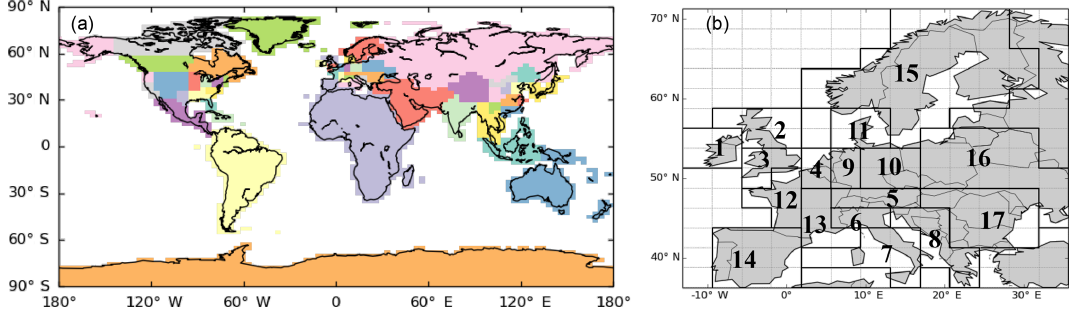
Figure 2. (a) Map of the 56 regions whose monthly emission budgets are controlled by the inversion; (b) zoom over the 17 control regions in Europe. In panel (a) , we repeatedly use 12 colors for non-adjacent regions. For example, the northern Europe, Middle East, one region in the USA and one region in China are all red. But since they are in different continents, they represent four different